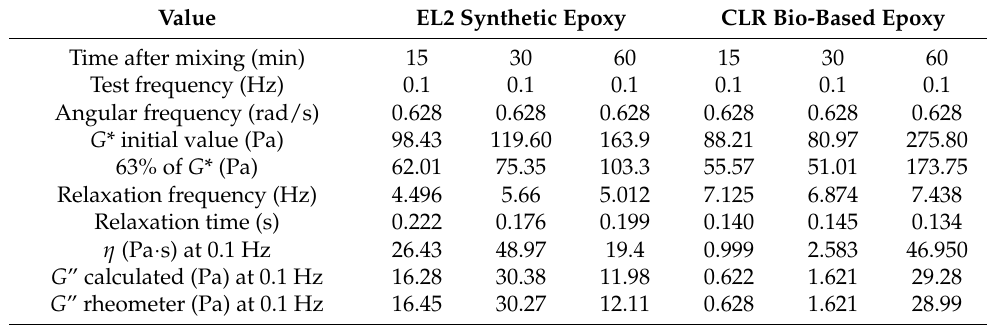
Table 3. Result of Maxwell